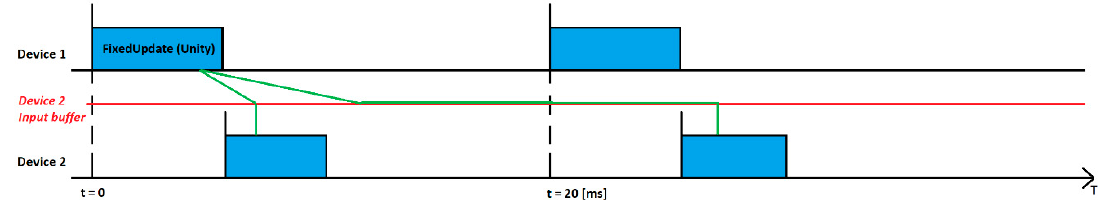
Figure 4. System delay example. Two devices are running a Unity-based application, which executes send/receive tasks each 20 ms. Two packages with different base delay incurs in none and 20 ms system delay.